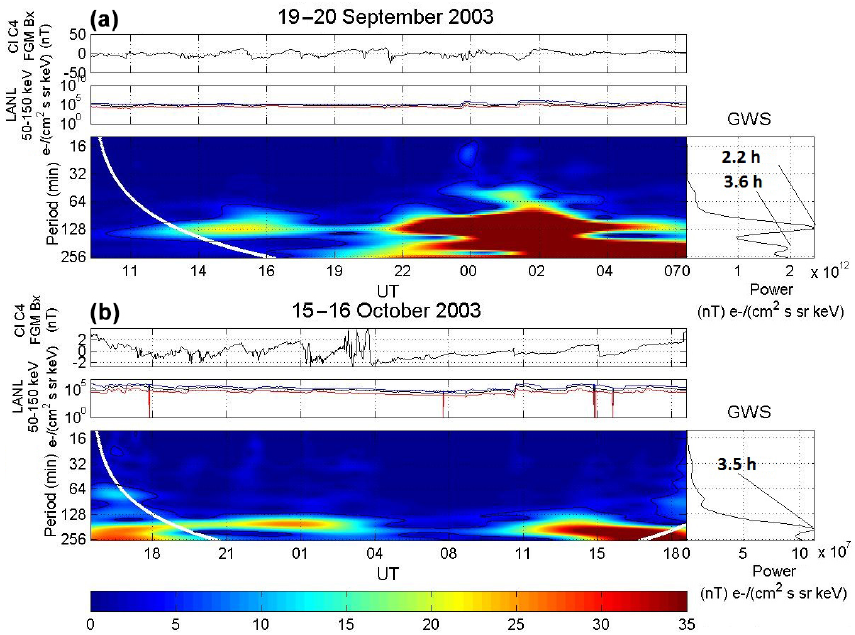
Figure 7. Cross-wavelet spectra between Cluster B x component data and three LANL electron channels for the (a) 19–20 September 2003 tail crossing (T2) and for the (b) 15–16 October 2003 tail crossing (T5). Otherwise the format is the same as Fig.